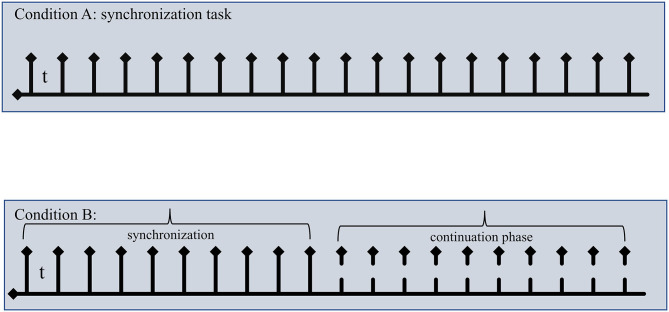
A schematic representation of sensorimotor synchronization task. Top: In Condition A, subjects were asked to tap in synchrony to “beep. Bottom: in Condition B, subjects tapped in synchrony for the first 10 taps, then beeps stopped, and subjects continued to tap at same tempo in the so-called continuation phase (the last 10 taps). The last 10 taps for both conditions were used in the analysis. t: intertone interval 1000 ms or 2000 ms; solid arrow indicated taps in the synchronization phase; dashed arrows indicated when beep stopped.